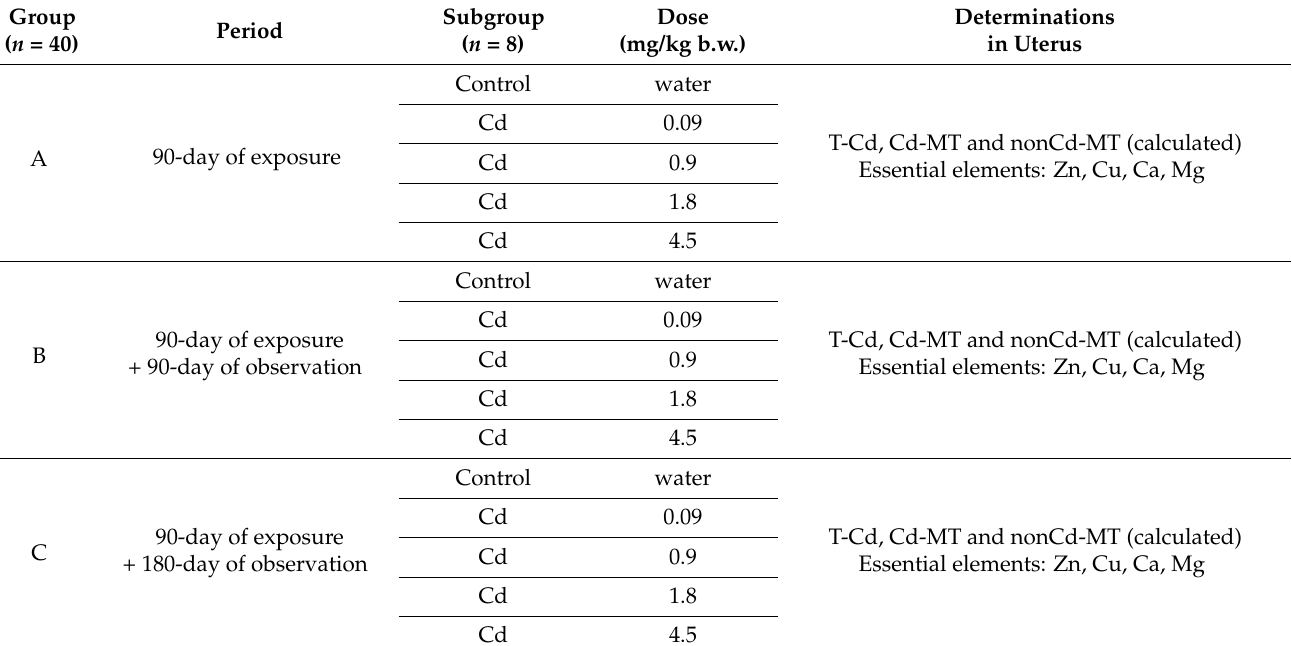
Table 2. Experimental groups, periods, dose and tested